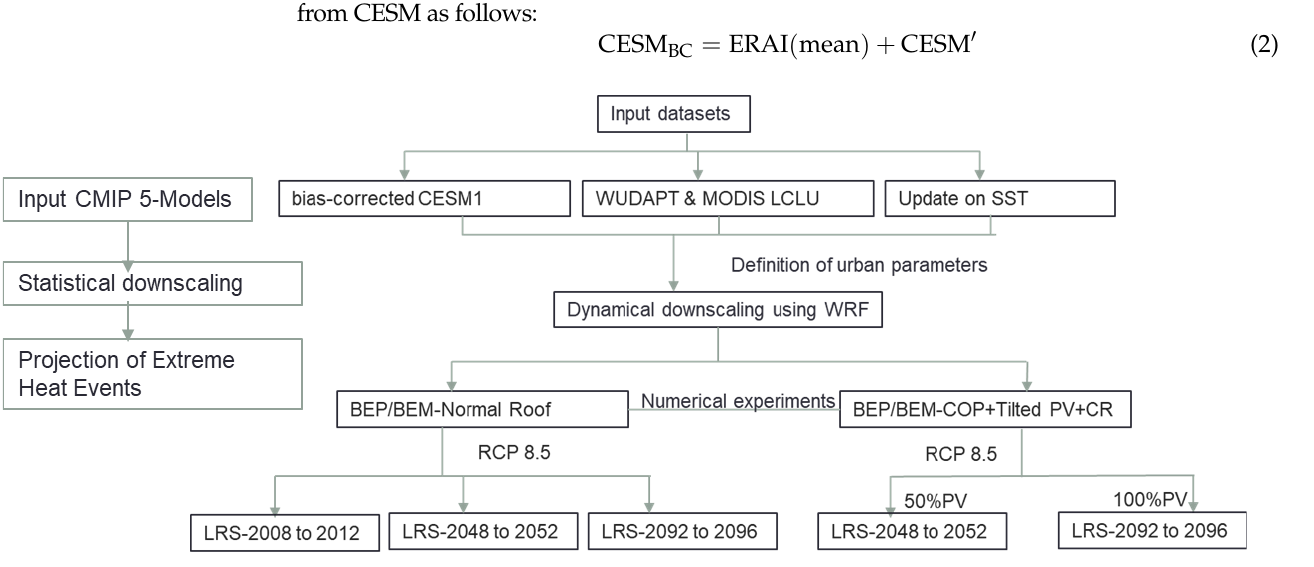
Figure 1. The overall methodology adopted in this study.